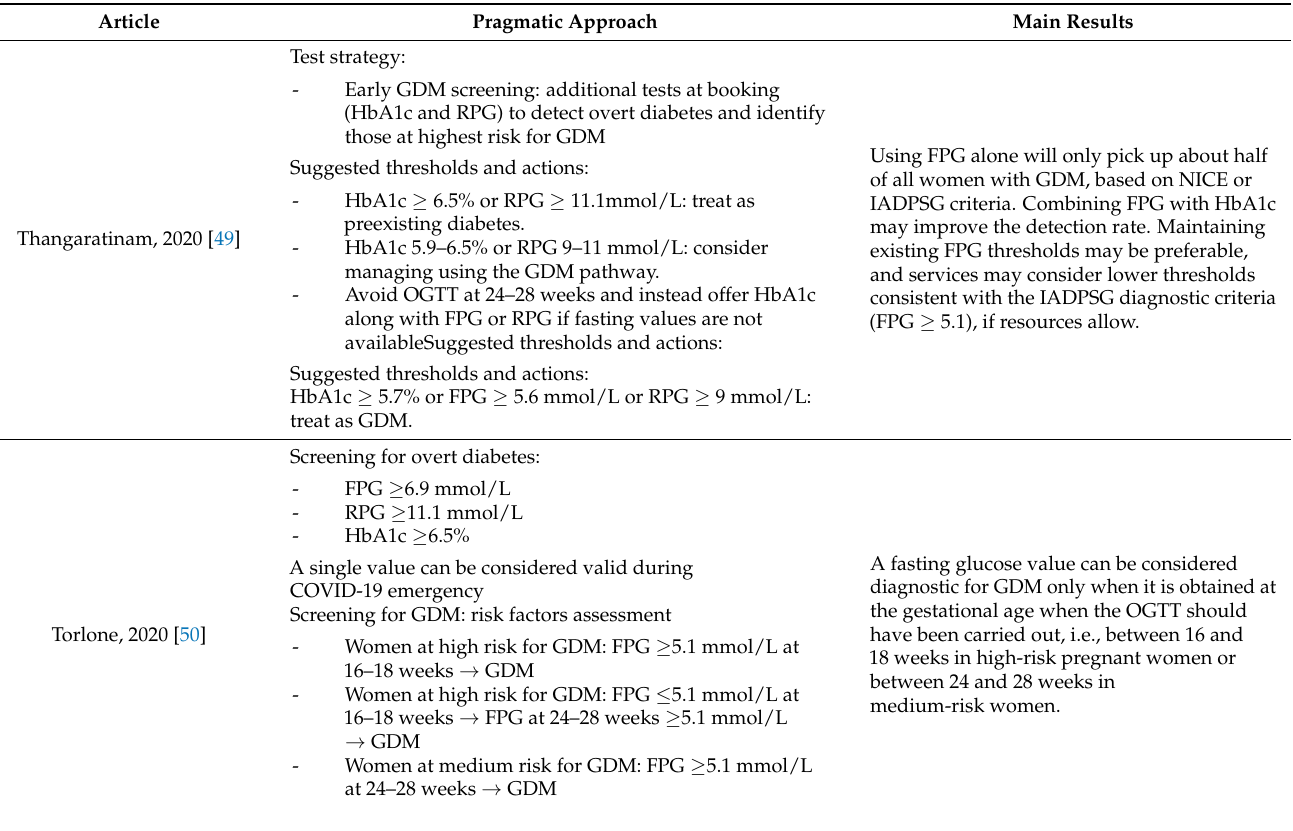
Table 3. Screening for diabetes and GDM (early) in pregnancy in COVID